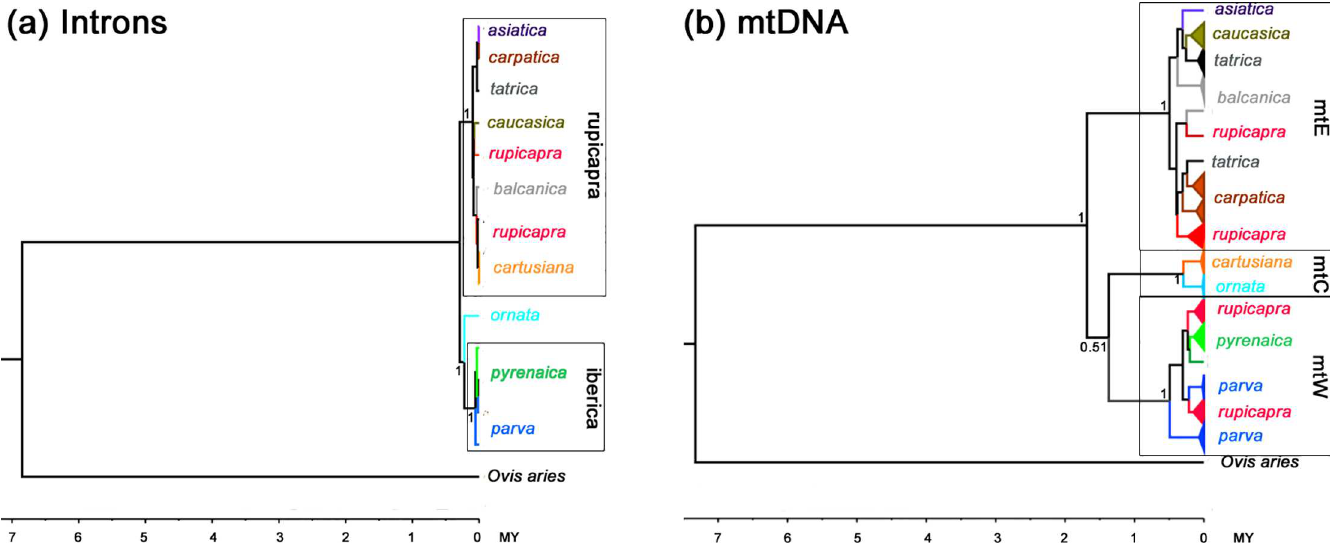
Fig 4. Comparison of intron and mtDNA gene trees. StandardBEAST analysisof: a) concatenated intron sequences(15382nt) and b) concatenate mtDNA sequences(1646 nt), modifiedfrom [19]. The numbersat the nodesare posterior probabilities.